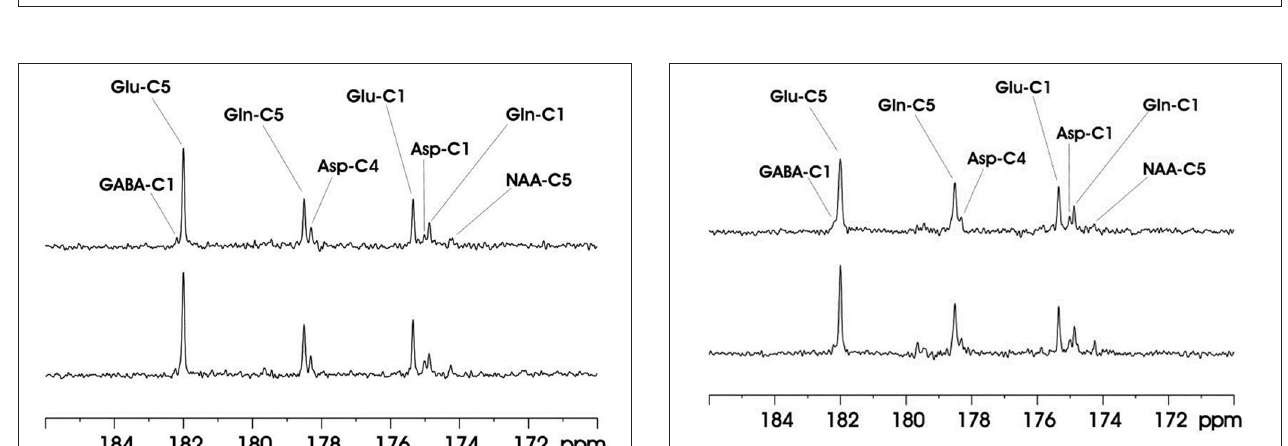
ppm. NOE was accomplished via a train of nonselective hard